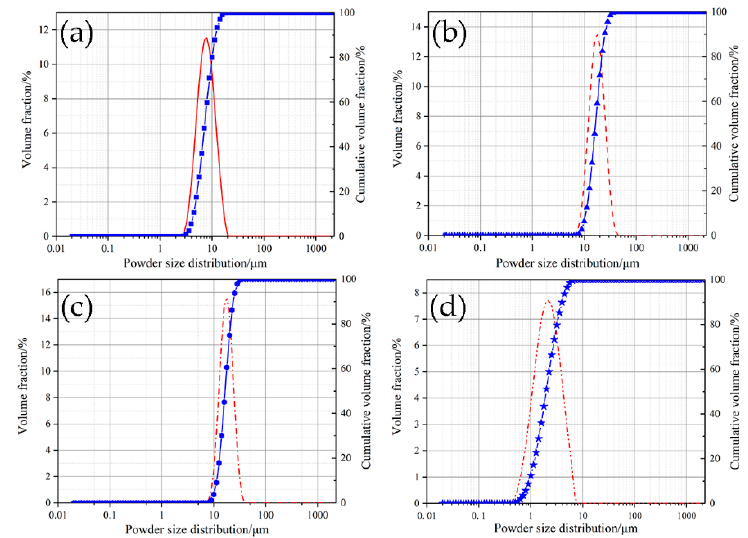
Figure 2. The distribution of Four kinds of powder sizes. ( a ) Pure tungsten powder; ( b ) nickel powder; ( c ) Fe-Ni alloy powder; ( d ) submicron nickel powder.